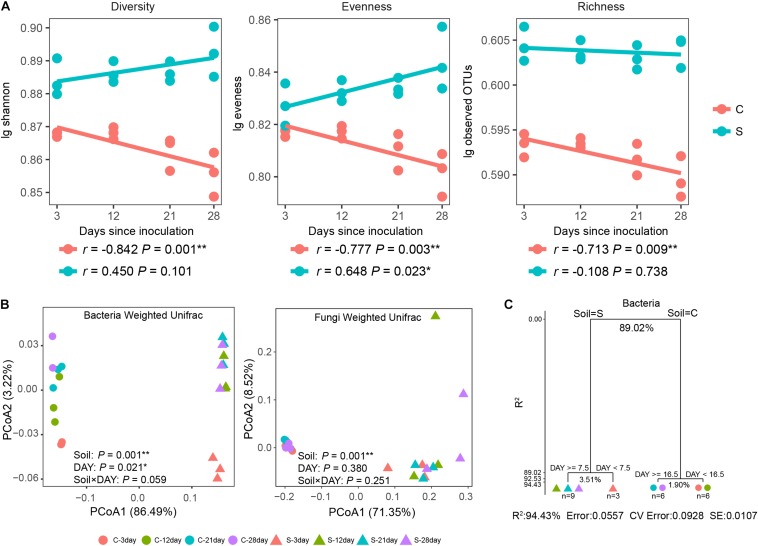
Alpha diversity illustrates different trends between treatments with shifts in community composition since disease-causing Fusarium inoculation. (A) Spearman correlations (r) between bacterial alpha diversity and days since inoculation. Statistical tests are provided in Supplementary Table S2. (B) PCoA clusters of the bacterial and fungal community composition based on Weighted UniFrac distance metrics. (C) Multiple regression tree analysis of the impacts of soil suppressive status and days since inoculation on bacterial community composition at the genus level. Numbers under the crosses of each split indicate percentages of variance explained. Points represent individual samples, and colors indicate days since inoculation. C, circles, disease-conducive soil; S, triangles, disease-suppressive soil. An asterisk denotes a statistically significant correlation (∗P < 0.05 and ∗∗P < 0.01).